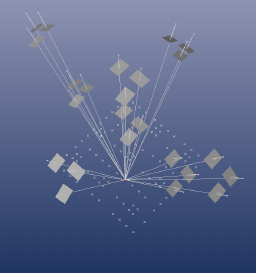
Figure 5: The synthetic network consisted of 24 cameras at vary- ing roll angles. The simulated targets were in a 3D configuration with a largest dimension of 1000 mm.